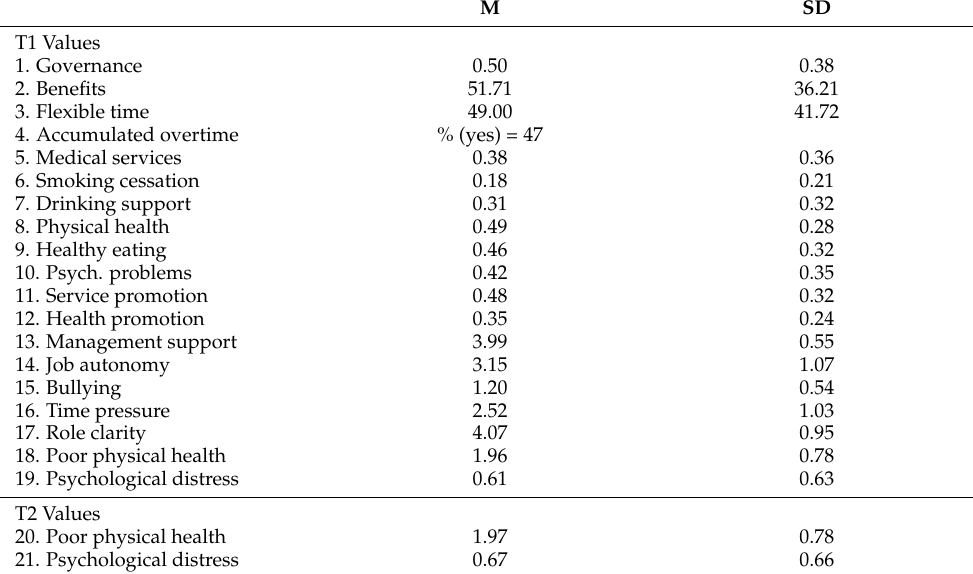
Table 1. Descriptive